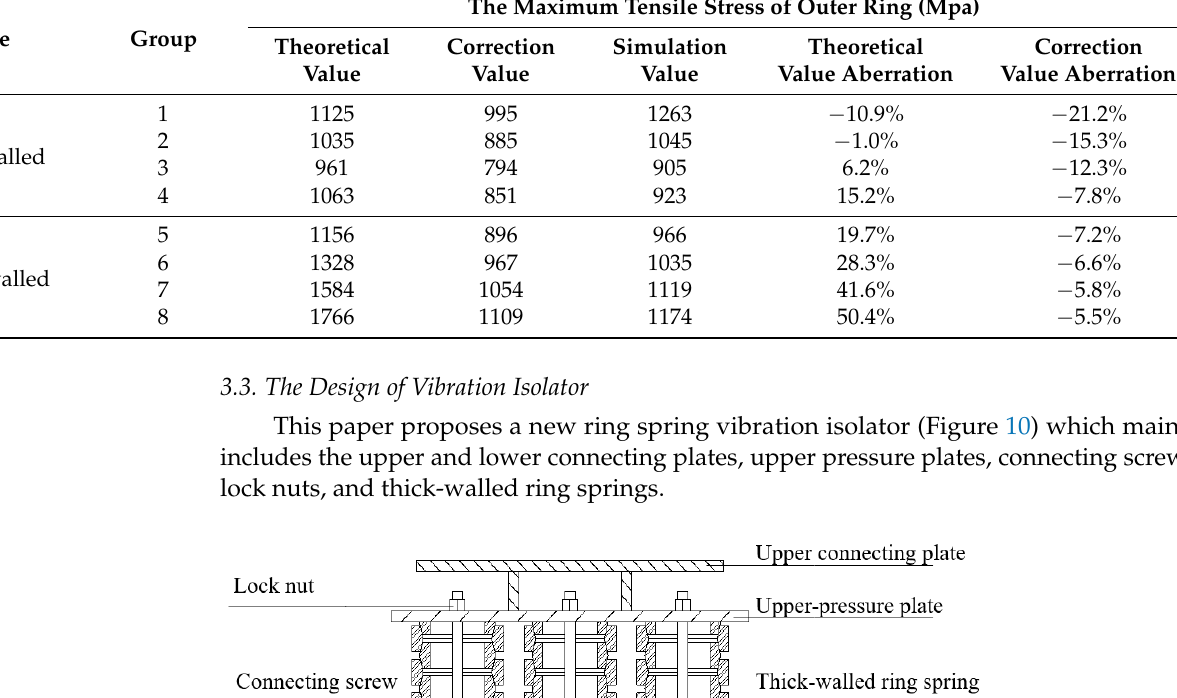
Table 3. Comparative analysis of the maximum tensile stress of the outer ring by theoretical calculation and numerical simulation.